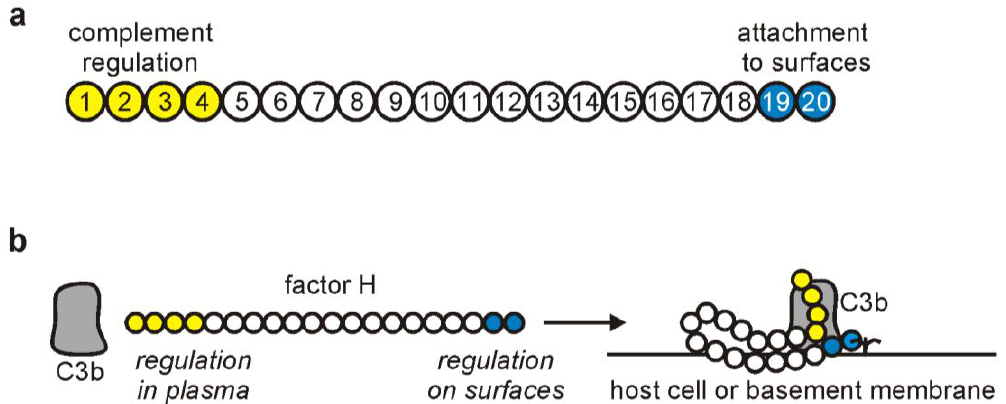
Figure 2. The schematic structure of factor H. (a) Factor H is composed of 20 short consensus repeat (SCR) domains. Two major functional regions are located at the N- and C-termini of the molecule. SCRs 1-4 mediate the complement regulatory activities of factor H; (b) The SCRs 19-20 allow the attachment of factor H to host cells so that it can also inhibit complement activation directly at the cell